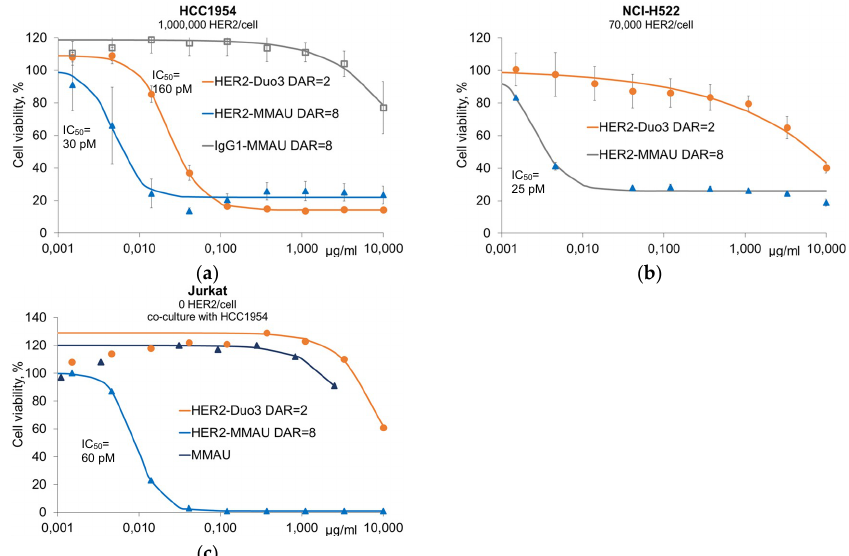
Figure 3. In vitro cytotoxicity of anti-HER2 ADCs against HER2-expressing cancer cell lines. ( a ) For high copy number HER2-expressing cells, both anti-HER2 DAR = 8 MMAU ADC and DAR = 2 duostatin-3 ADC showed high cytotoxic activity, while both anti-HER2 naked antibody and an isotype IgG control antibody-MMAU conjugate showed only no or low cytotoxicity, respectively. All experiments were performed in triplicate except for anti-HER2 naked antibody; ( b ) For low copy number HER2-expressing cells, the anti-HER2 DAR = 8 MMAU ADC had superior activity compared with DAR = 2 duostatin-3 ADC. Both experiments were performed in triplicate; ( c ) To demonstrate bystander kill activity of MMAU ADCs, non-HER2-expressing Jurkat cells were co-cultured with HCC1954 cells that express HER2, and viability of Jurkat cells was measured after incubation with fluorescence-assisted cell sorting (FACS)-based assay. The anti-HER2 DAR = 8 MMAU ADC showed bystander kill activity, while neither the anti-HER2 DAR = 2 duostatin-3 ADC nor the free MMAU payload had cytotoxic activity towards Jurkat cells. The results are from a single representative experiment. IC 50 values are marked in the figure panels and they were determined using curve fitting by nonlinear regression as the concentration of the drug that causes 50% inhibition of cell viability compared to maximum inhibition. Error bars show the standard error of the mean, where